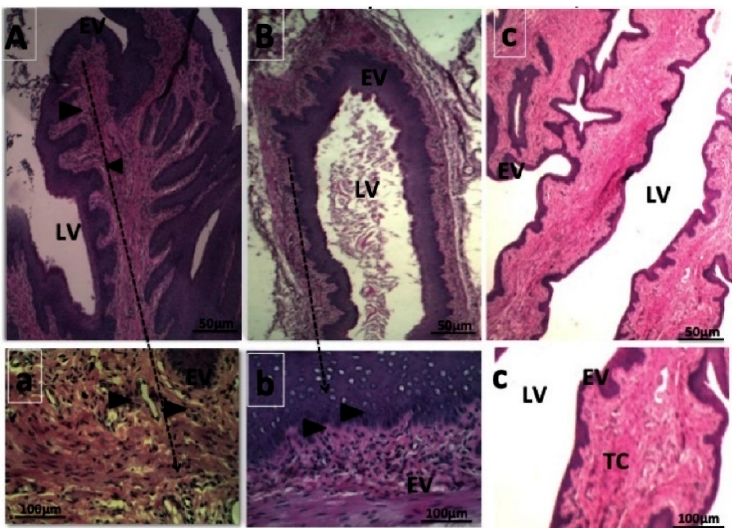
Figure 3. Histological sections of the endocervix collected 24 h post-infection. ( A ) Infected control receiving no treatment (Group 1). The vaginal lumen (LV) showed Candida albicans hyphae. The vaginal epithelium (EV) showed inflammatory cells. ( a ) Head arrow indicated the inflammatory infiltrate. ( B ) Infected and untreated animals receiving EUD (Eudragit) nanoparticles/hyaluronic acid (HA) (Group 2). The LV showed intense colonization by Candida albicans . The EV showed an inflammatory process. ( b ) Head arrow indicated the inflammatory infiltrate. ( C ) Infected and treated animals receiving AMP EUD nanoparticles/HA (Group 4). The LV showed no fungal infection and the inflammation was not evident. ( c ) The integrity of the EV and fibroelastic connective tissue (TC) after treating by AMP released from EUD nanoparticles/HA. Adapted from “Amphotericin B-loaded Eudragit RL100 nanoparticles coated with hyaluronic acid for the treatment of vulvovaginal candidiasis” by Melo [77].